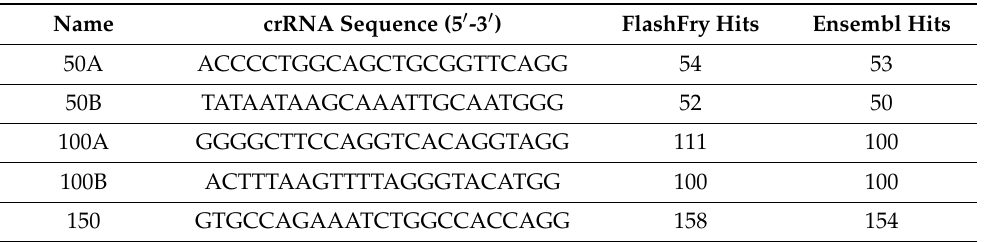
Table 1. Candidate sequences for promiscuous targeting of the human genome. Predicted number of hits are presented from FlashFry and